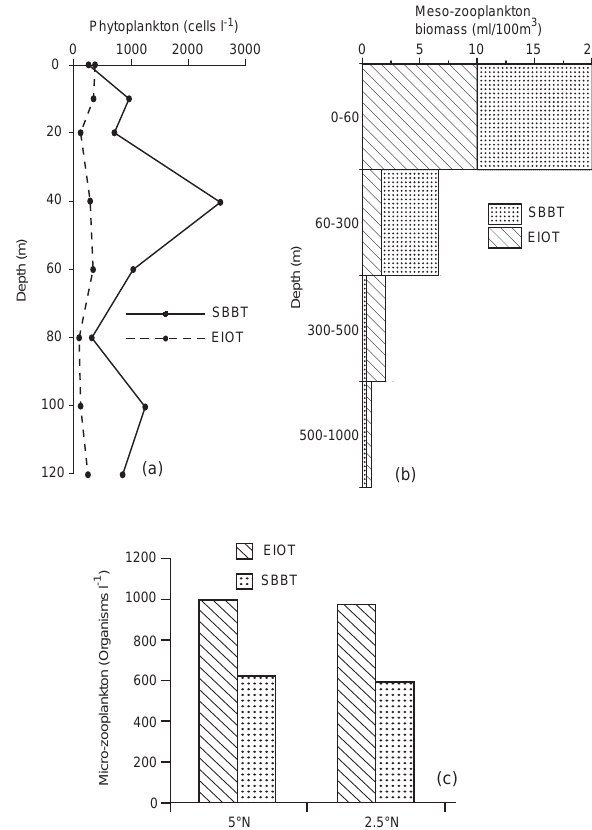
Fig. 12. Vertical profiles of (a) phytoplankton abundance (cellsL − 1 ) in the vicinity of SBBT (solid line) and EIOT (broken line) (b) vertically stratified meso-zooplankton biomass in the vicin- ity of SBBT (dots) and EIOT (hatches) and (c) Micro-zooplankton (organismsL − 1 ) at selected stations along SBBT (dots) and EIOT (hatches) during August 2006.